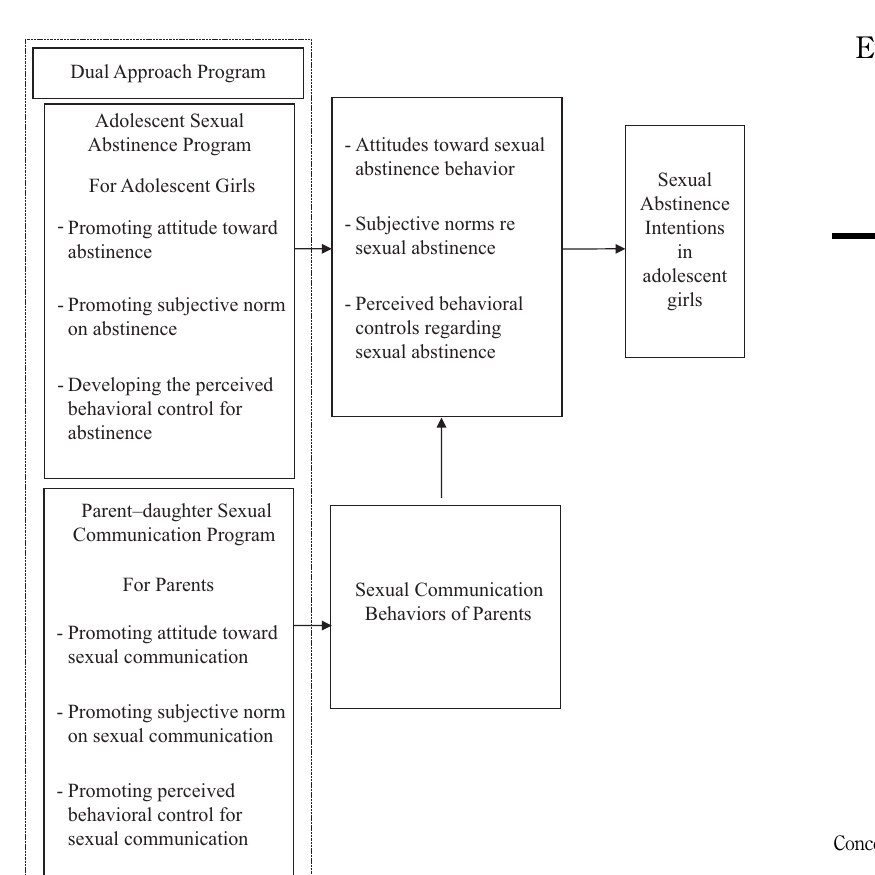
Figure 1. Conceptual framework of the